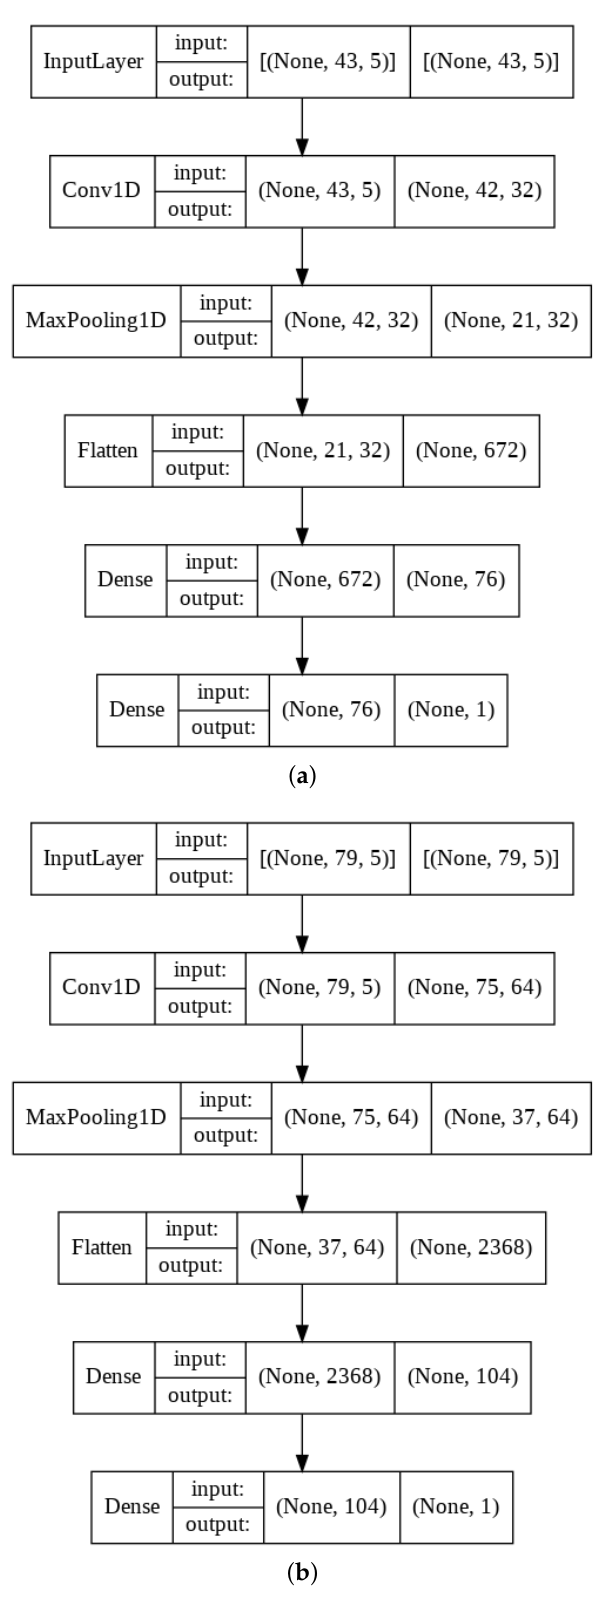
Figure 8. The CNN architecture of JNJ stock. ( a ) Half-day trading delay ( m = 43). ( b ) One-day trading delay ( m =